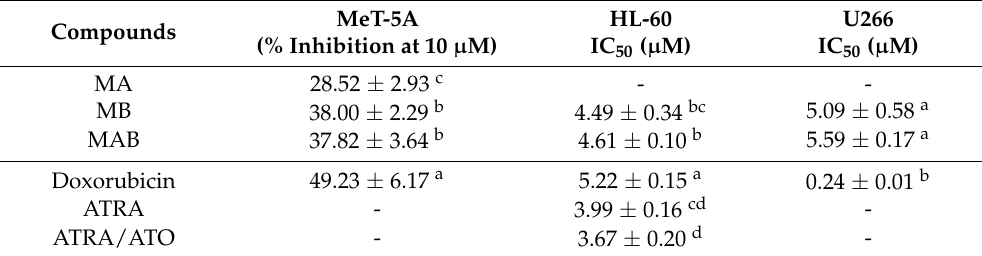
Table 1. Cytotoxic activities of momilactones A and B against MeT-5A, HL-60, and U266 cell